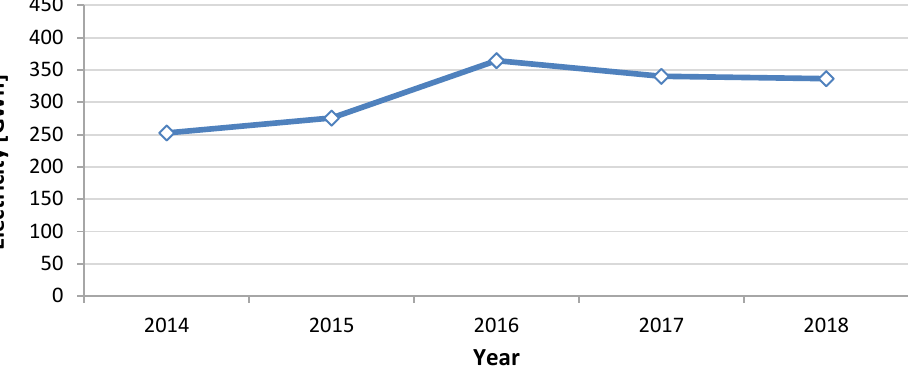
Figure 4. Production of electricity from biogas in WWPS in 2014–2018, authors’ own elaboration based on statistical data [62].